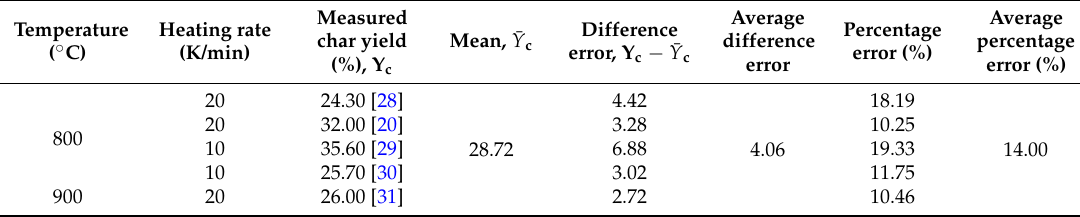
Table 2. Experimental error of six BA-a char yield measurements conducted at different temperatures and heating rates.